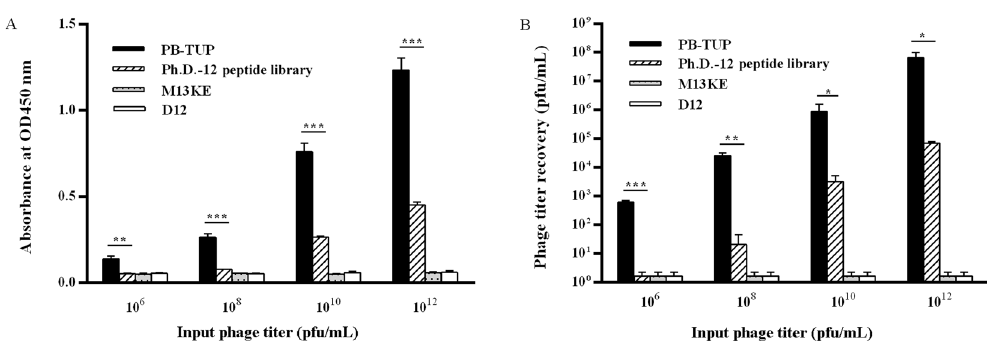
Figure 5. Concentration dependent binding to polystyrene. Different amounts (10 6 , 10 8 , 10 10 and 10 12 ) of the phages were added to the microtiter wells and the binding phages were measured by the absorbance ( A ) or titers of recovered phages ( B ). All phage clones bound to polystyrene in a concentration dependent manner. PB-TUP phage exhibited a significantly stronger binding comparing with the other groups in both ELISA absorbance and phage